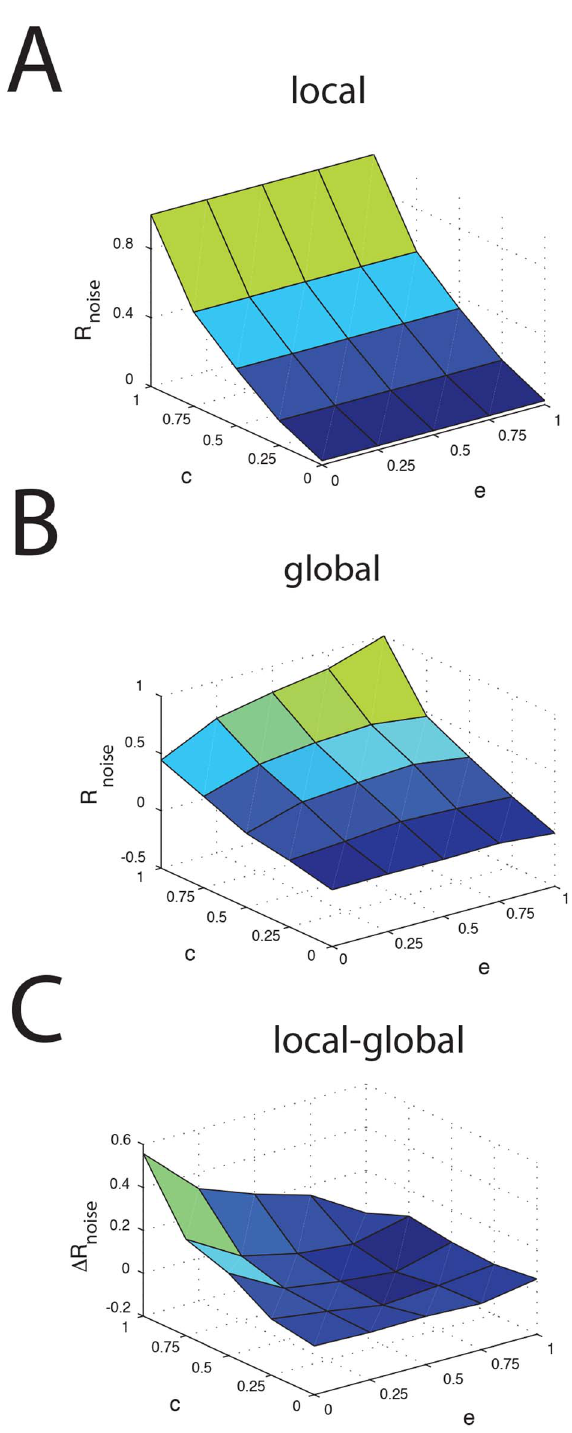
Fig. 5. Correlated variability between SPs and granule cells influences noise correlations. A ) Noise correlation coefficient as a function of the input noise correlation coefficient c for the SP cells and of the fraction of shared noise with the SPs e for local stimulation. B ) Noise correlation coefficient as a function of c and e for global stimulation. C ) Reduction (local-global) in noise correlation coefficient as a function of c and e .